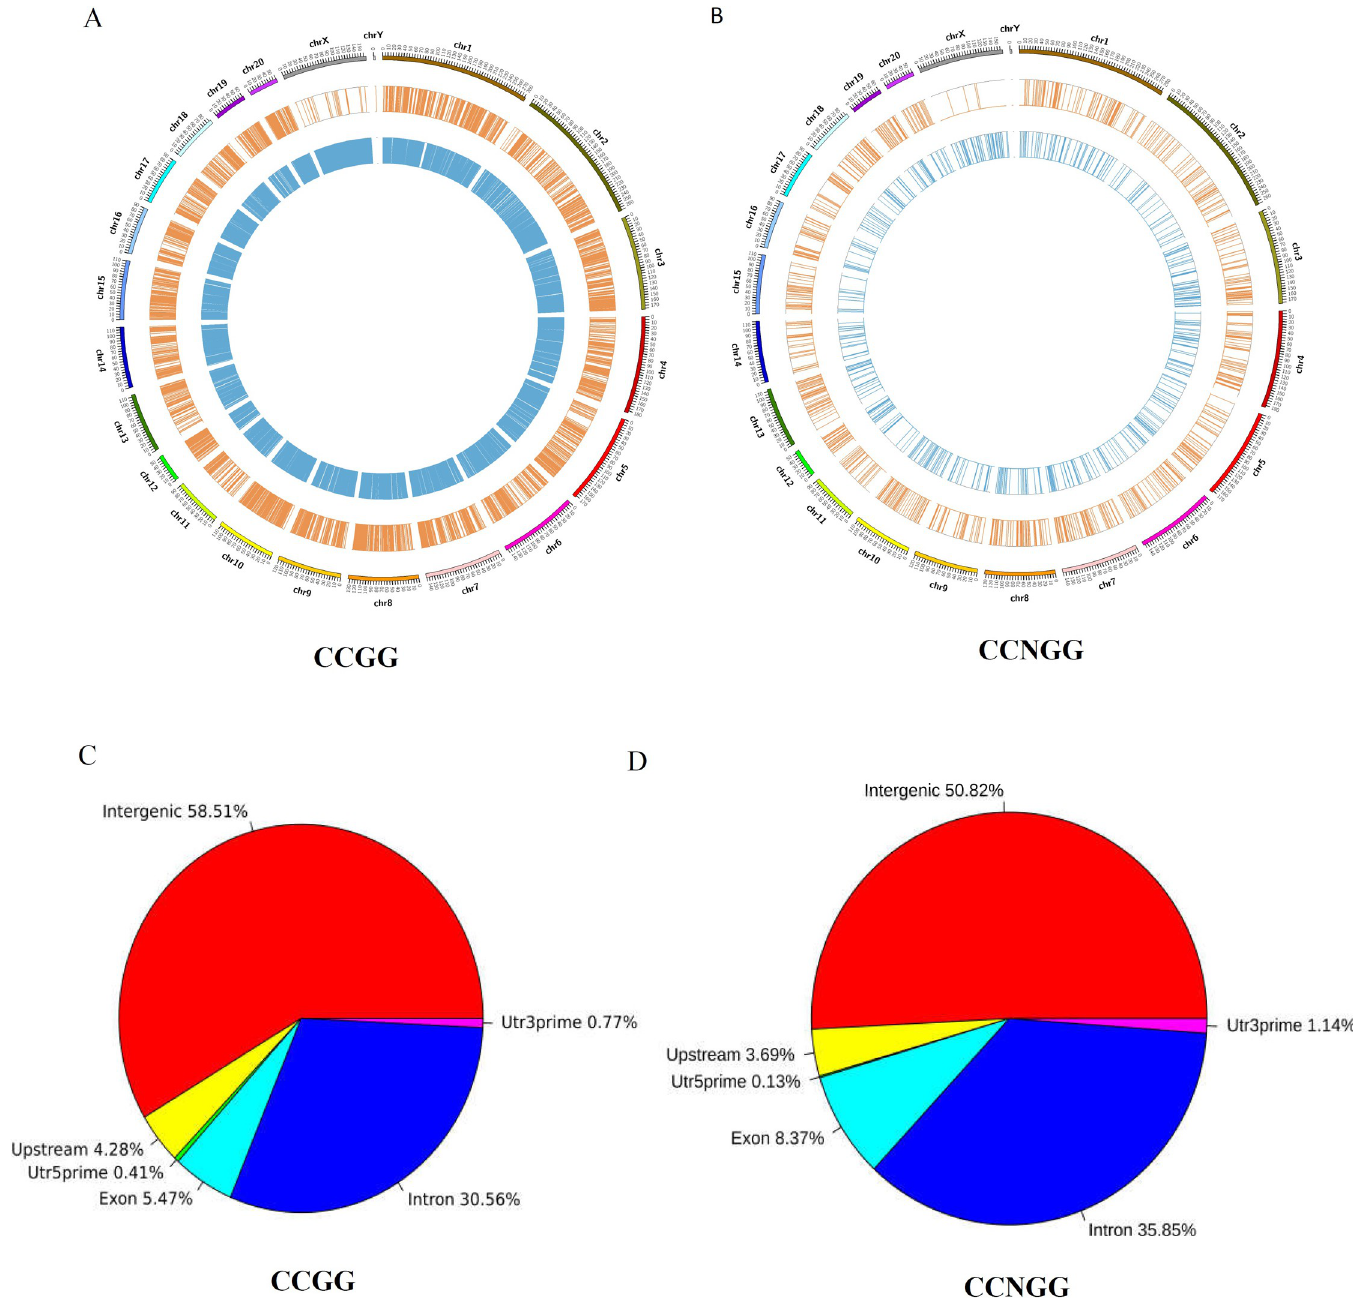
Fig 4. Distribution of differential methylation sites on genes of chromosomes and different functional components. (A) Distribution of differential CCGG methylation sites on chromosomes. (B) Distribution of differential methylation CCNGG sites on chromosomes. (C) Distribution of differential CCGG methylation sites on genes of different functional components. (D) Distribution of differential CCNGG methylation sites on genes of different functional components. https://doi.org/10.1371/journal.pone.0268117.g004 value < 0.05 are listed in Fig 6. The CCGG-based DMGs involved in biological process were mainly related to the regulation of transcription from RNA polymerase II promoter and tran- scription, DNA-templated. The CCGG-based DMGs involved in the cellular component were mainly related to the endoplasmic reticulum and mitochondrial membrane. The CCGG-based